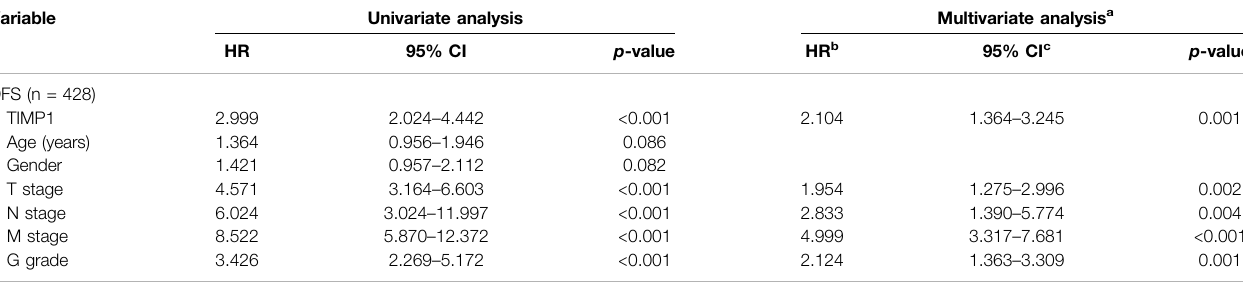
TABLE 3 | Univariate and multivariate analyses of TIMP1 mRNA level and patient disease-free survival.